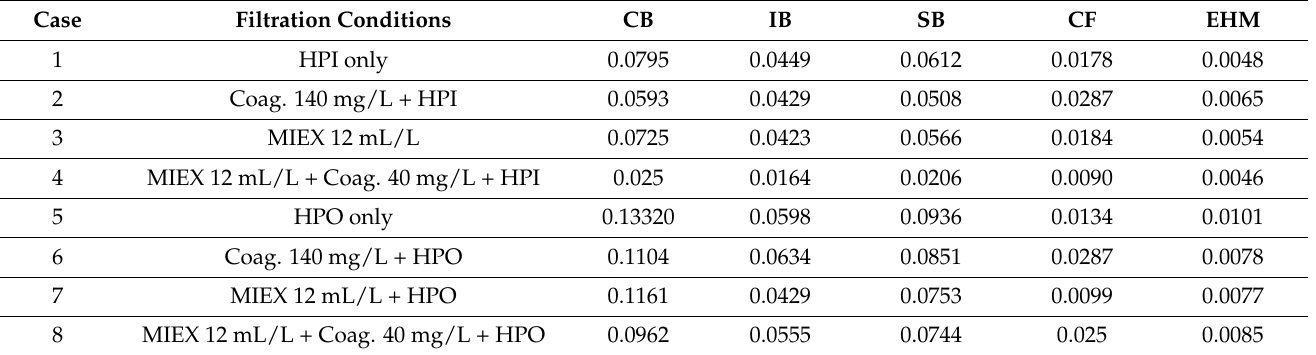
Table 3. RMSE results obtained in Example 1.